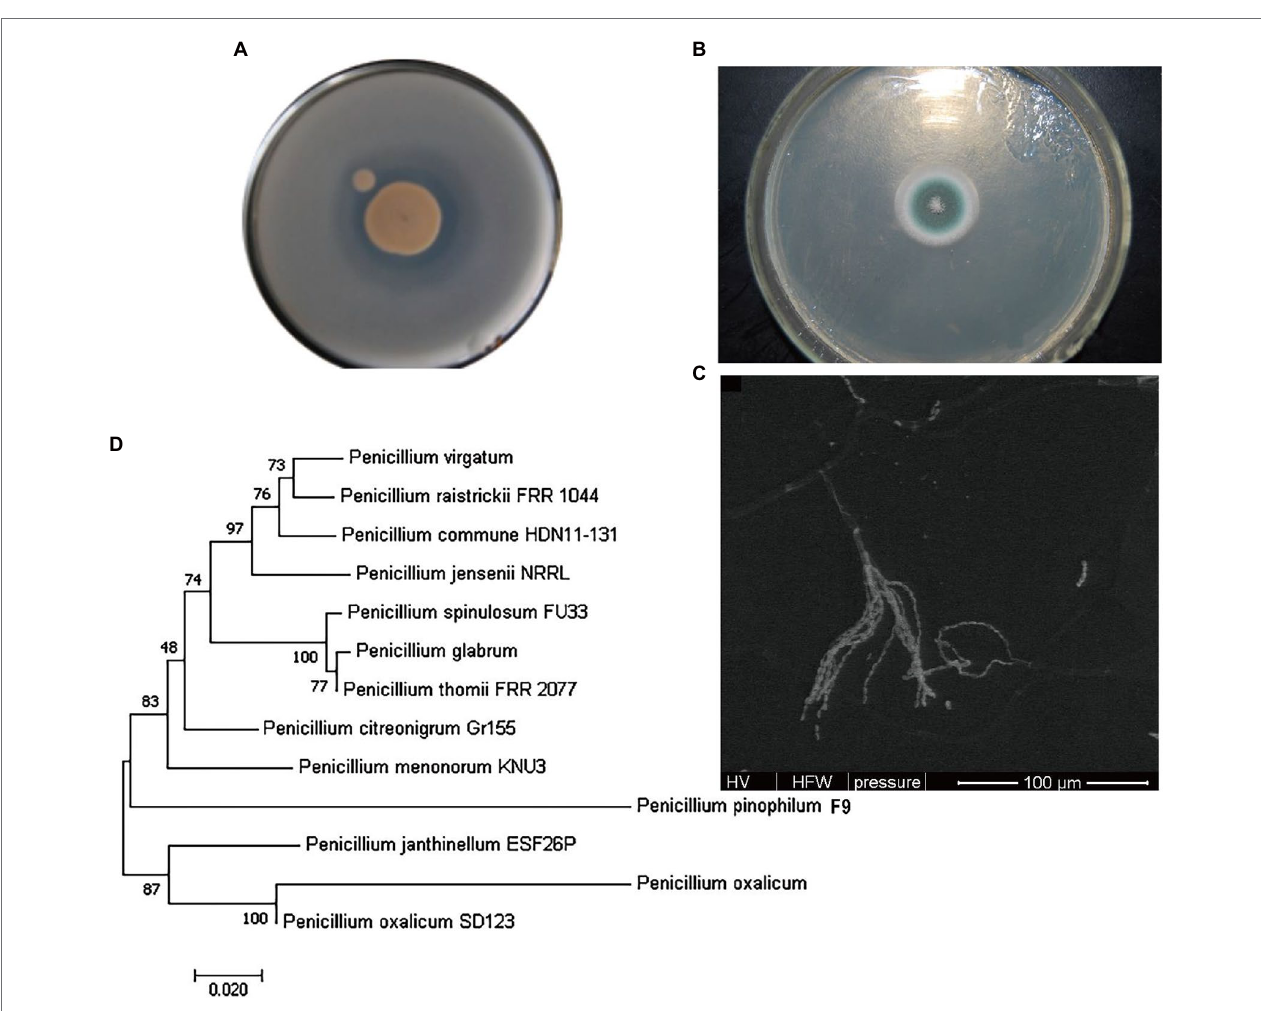
FIGURE 2 | Identification of phosphate-solubilizing fungus F9. (A) Colony of F9. (B) Solubilized (halo) zone of F9. (C) Electron micrograph of F9. (D) Phylogenetic tree of